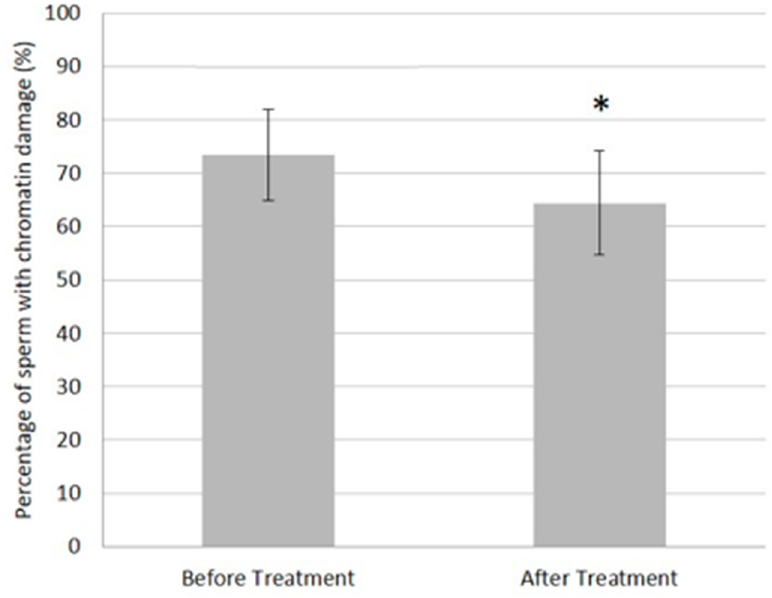
Figure 2. Evolution of sperm chromatin integrity. Sperm chromatin integrity was monitored before and after varicocele embolization, as described in the Methods section. * p = 0.043. Sperm chromatin integrity was assessed as previously described [22]. n = 86.